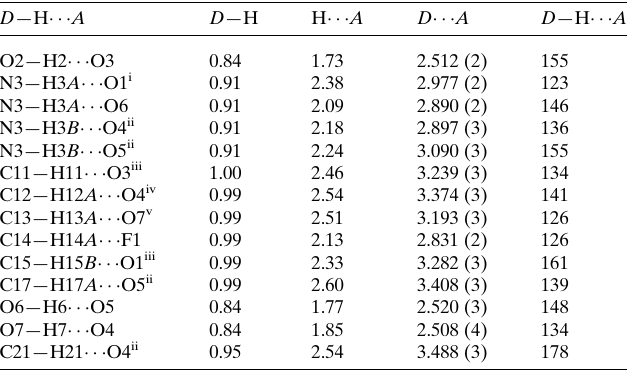
Table 1 Hydrogen-bond geometry (A˚ , (cid:4) ) for (I).